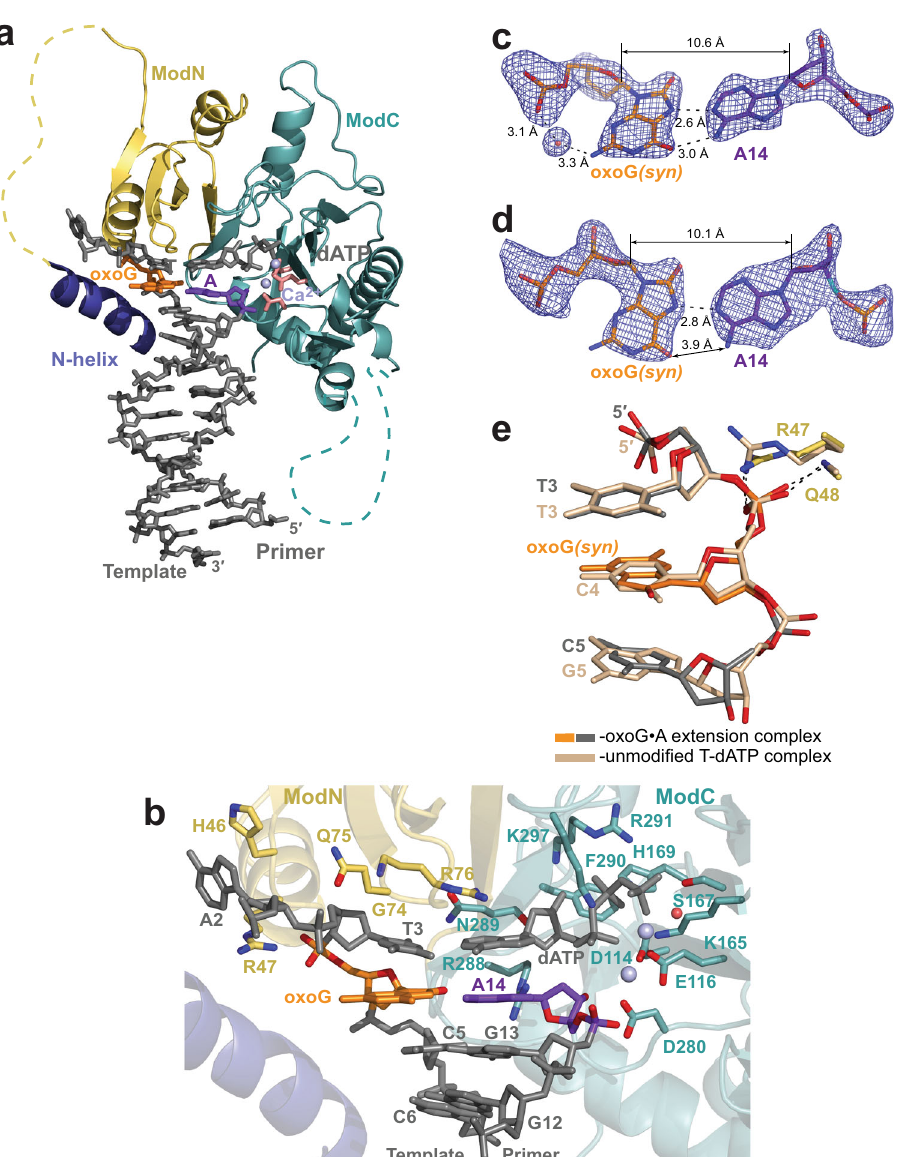
Fig. 4 Structure of human PrimPol extending from an incorrect primer A base opposite the oxoG template base. a The overall structure of the ternary PrimPol oxoG • A extension complex (molecule A of the asymmetric unit, AU). The N-helix and modules ModN and ModC are shown in cartoon representation in dark blue, yellow, and cyan, respectively. The DNA is shown as gray sticks, the two Ca 2 + ions (metals ‘ A ’ and ‘ B ’ ) are shown as light blue spheres. The oxoG residue (orange) is forming a base pair with the primer terminal A base (purple). The incoming dATP forms a nascent base pair with a template T base, which is 5 ′ -adjacent to the oxoG residue. The unstructured regions in the ModN and ModC modules are shown as dashed yellow and cyan lines, respectively. The side chains of key catalytic active-site residues Asp114, Glu116, and Asp280 are shown as red sticks. b A close-up view of the oxoG template base and the 3 ′ -deoxy primer C14 base in the PrimPol active site (molecule A in the AU). Two Ca 2 + ions (metals ‘ A ’ and ‘ B ’ ) in this complex shown as light blue spheres, and the water molecule coordinated by the Ca 2 + ion is shown as a small red sphere. c A simulated annealing Fo − Fc omit map (contoured at 2.5 σ -level at 2.07 Å resolution and colored in blue) showing the clear electron density for the oxoG residue in the syn conformation and its partner A14 residue in molecule B of the AU. The water molecule that facilitates the intramolelecular bond between the N 2 and the phosphate group of the oxoG residue is observed only in molecule B. d A simulated annealing Fo − Fc omit map (contoured at 2.5 σ -level) showing the electron density for the oxoG (syn) and its partner A14 residues in molecule A of the AU. There is only one hydrogen bond in this base pair. e Similar phosphate backbone conformations of T3-oxoG4 (syn) -C5 (gray and orange) and unmodi fi ed T3-C4-G5 (beige) template strand segments within the PrimPol active site of their respective ternary complexes. The main-chain nitrogen atom of Gln48 and the side chain of Arg47 contact the phosphate group of the oxoG (syn) similarly to the protein contacts with the phosphate group of C4 in the unmodi fi ed only one Ca 2 + ‘ ion B ’ chelated by the oxygen atoms of the tri- unit (AU) of the oxoG (cid:129) dCTP insertion complex and in molecules ‘ A ’ of the oxoG (cid:129) dATP insertion and the oxoG (cid:129) C extension phosphate tail of the incoming dATP as assumed due to the use of 2 ′ ,3 ′ -dideoxy primer terminus. Interestingly, in the current complexes. Thus, binding of dNTP together with ‘ ion B ’ to study, with the ‘ native ’ 3 ′ -OH-2 ′ -deoxy primers, a single Ca 2 + PrimPol-DNA appears to be the fi rst step in ternary PrimPol ‘ ion B ’ is detected in both complex molecules of the asymmetric complex assembly, similar to that observed for Y-family human